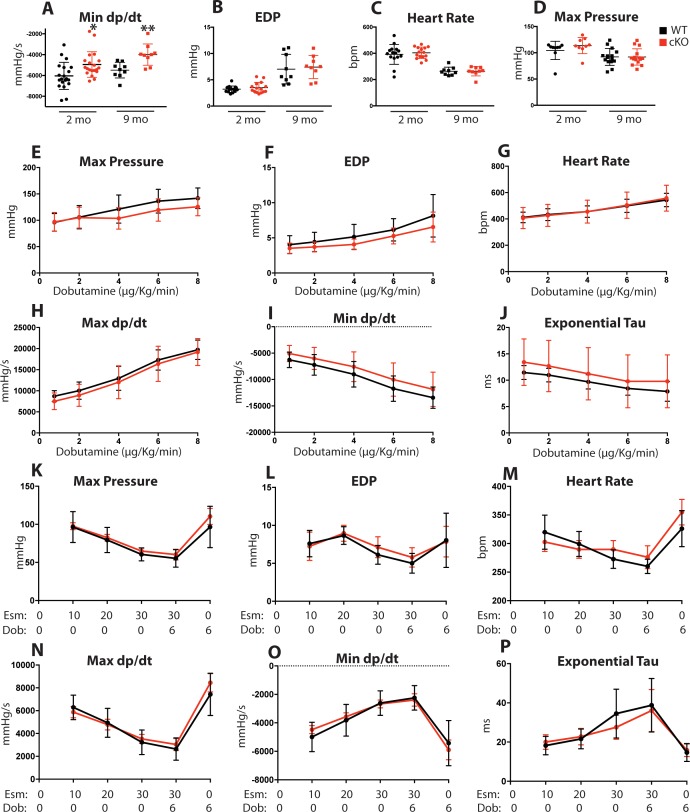
Role of Fam20C in the acute hemodynamic response to β-adrenergic receptor activation.(A–D) Changes in LV hemodynamic variables of 2 and 9 months old mice for (A) minimum dP/dt, (B) end-diastolic pressure, (C) heart rate in beats/min (bpm), and (D) maximum LV pressure (n = 9–20). (E–P) Changes in LV hemodynamic variables with dobutamine (n = 9) (E–J) and esmolol (n = 6) (K–P) infusion of 2 months old mice. Calculated values for (E) maximum LV pressure, (F) end-diastolic pressure (EDP), (G) heart rate in beats/min (bpm), (H) maximum dP/dt, (I) minimum dP/dt, and (J) time constant for relaxation (Tau). Dobutamine doses are given in micrograms per kilogram per minute. Calculated values for (K) maximum LV pressure, (L) end-diastolic pressure (EDP), (M) heart rate in beats/min (bpm), (N) maximum dP/dt, (O) minimum dP/dt, and (P) time constant for relaxation (Tau). Esmolol doses are given in milligrams per kilogram per minute. Data are represented as the mean ±SEM. *p < 0.05; **p < 0.01, by Student’s t test for WT v. cKO.